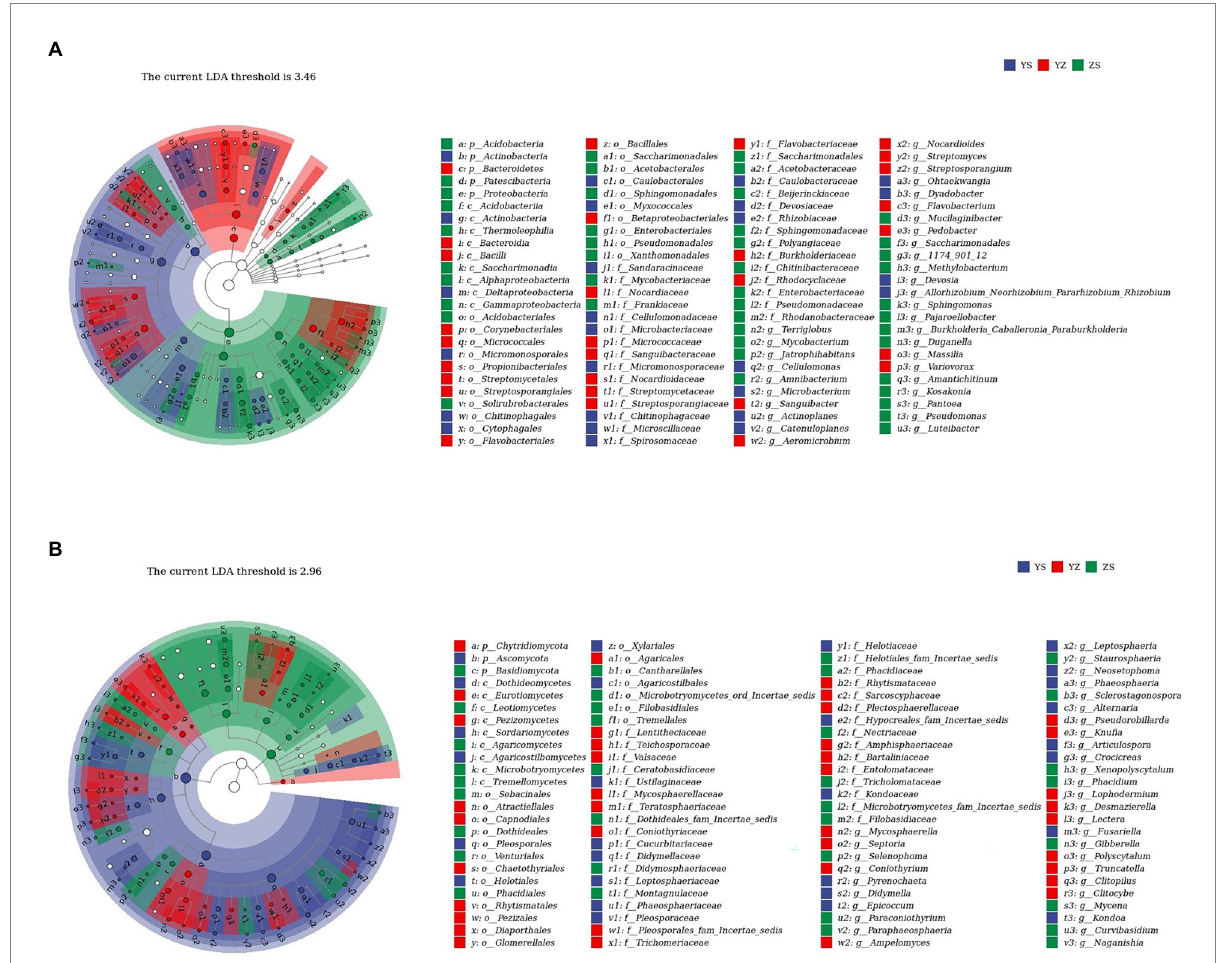
FIGURE 7 (A) Lefse with an LDA of 3.46 indicates that the 100 groups are significantly different between litter bacterial communities of YS, YZ, and ZS. (B) Lefse with an LDA of 2.96 indicates that the 100 groups are significantly different between litter fungal communities of YS, YZ, and ZS. YS: Populus × canadensis Moench; YZ: Populus × canadensis Moench- Pinus sylvestris var. mongolica ; ZS: Pinus sylvestris var. mongolica. Circle radiation from inner to outer of evolutionary branch figure represents the classification of the level from phylum door genus; every small circle represents the level of a classification in different classification level. The diameter of the circle is prportional to the relative abundance.